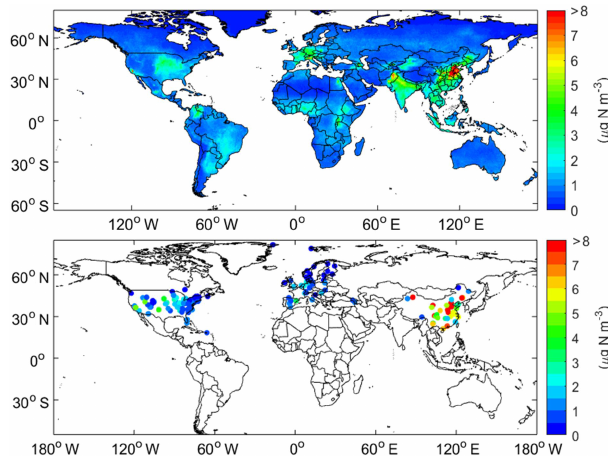
Figure 2. Spatial distribution of satellite-derived and measured sur- face NH 3 concentrations in 2014.